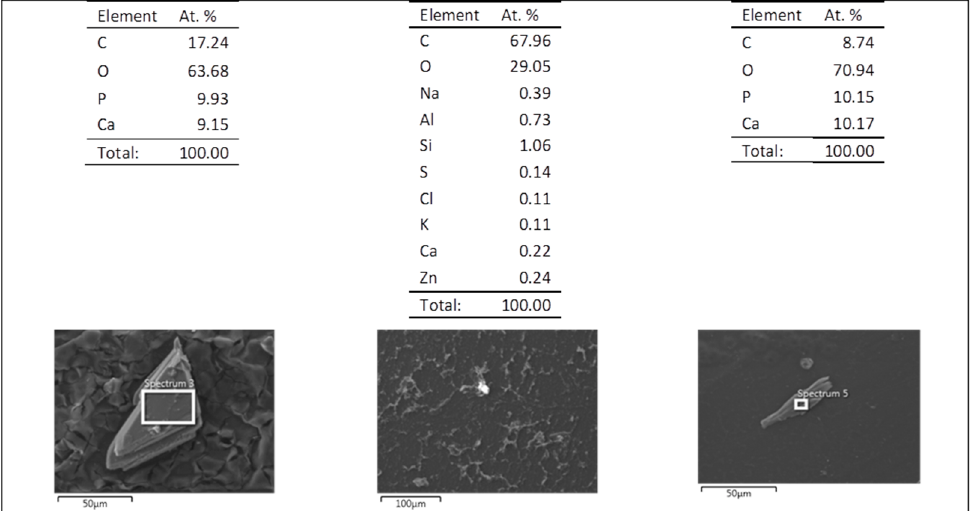
Figure 20. Chemical composition of three different precipitates formed at the surface of ZnO@PP sample after immersion in artificial urine for 21 days.